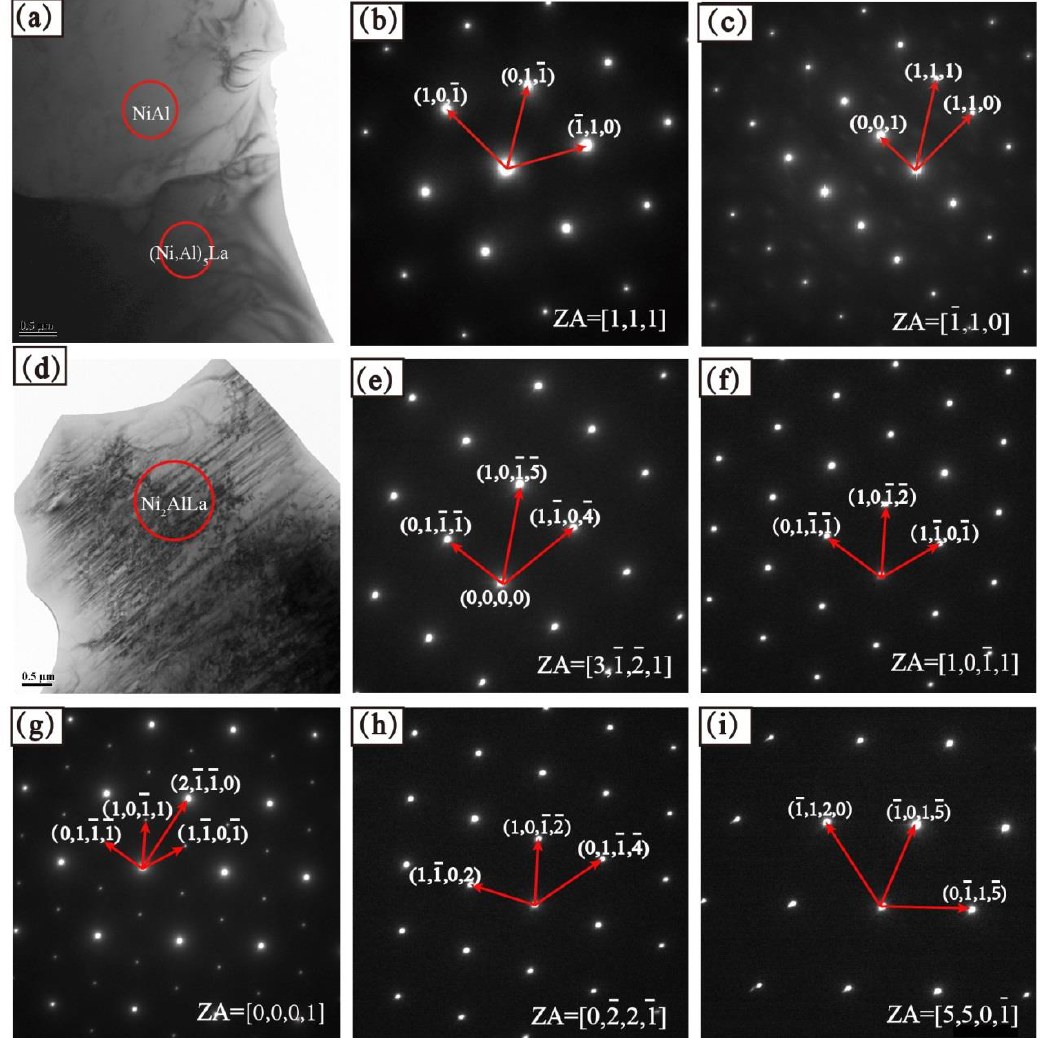
Figure 4. Crystal morphology and SAED patterns of #3 alloy annealed at 800 °C for 30 days. ( a ) crystal morphology of NiAl and (Ni, Al) 5 La phase, ( b ) SAED image of NiAl phase with zone axis of [111], ( c ) SAED image of (Ni,Al) 5 La phase with zone axis of [1 11], ( d ) crystal morphology of Ni 2 AlLa phase, ( e ) SAED image of Ni 2 AlLa phase with zone axis of [31 2 1], ( f ) SAED image of Ni 2 AlLa phase zone axis of [10 11], ( g ) SAED image of Ni 2 AlLa phase with zone axis of [0001], ( h ) SAED image of Ni 2 AlLa phase with zone axis of [0 22 1], ( i ) SAED image of Ni 2 AlLa phase with zone axis of [550 1].